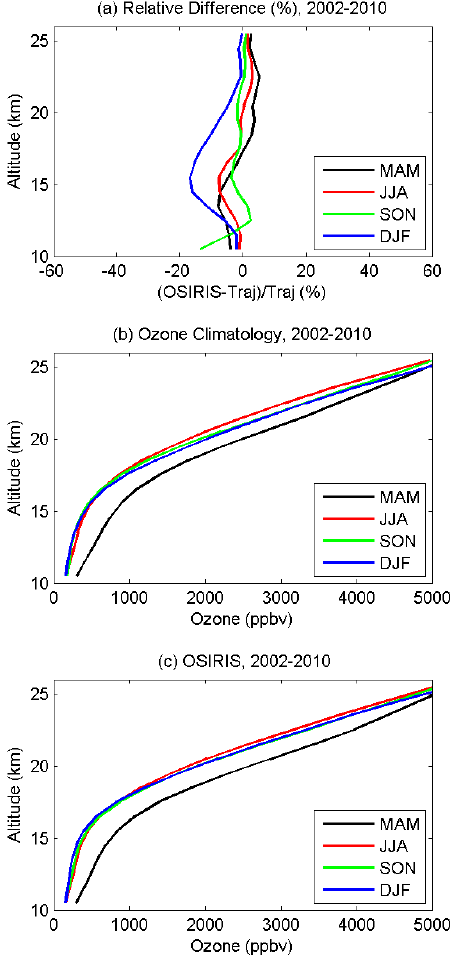
Fig. 8. (a) Relative difference between the trajectory-derived ozone climatology and OSIRIS data in four seasons, (b) global mean ozone profiles from the ozone climatology in four seasons, and (c) global mean ozone profiles from OSIRIS in four seasons (NH spring: MAM, summer: JJA, fall: SON, winter: DJF).